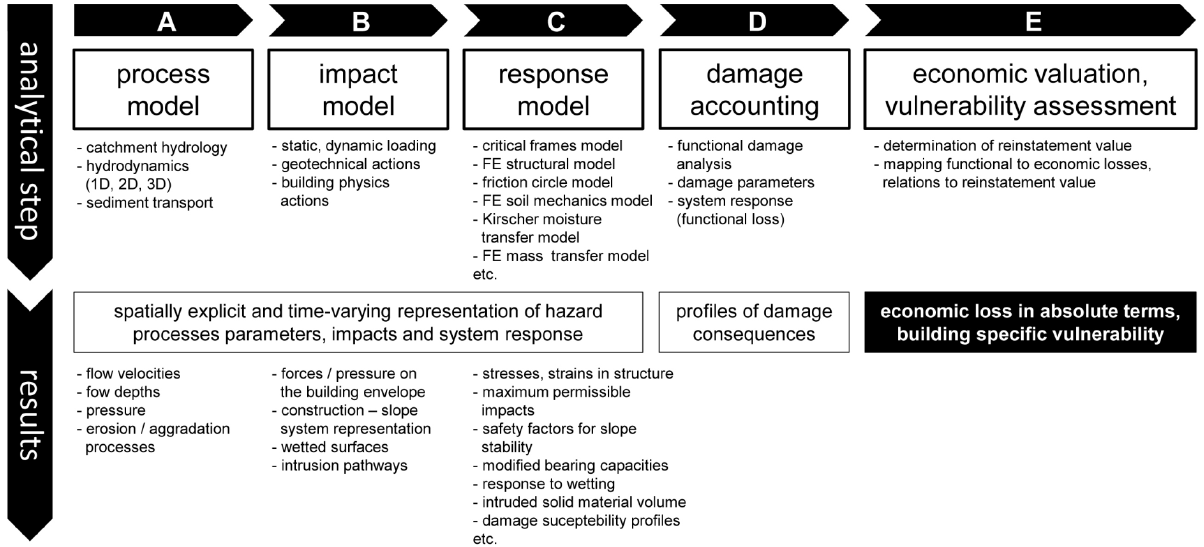
present case study analysis is a priori-constrained to pure wa- ter floods (WFL according to Heiser et al., 2015) and aimed mainly at the following research